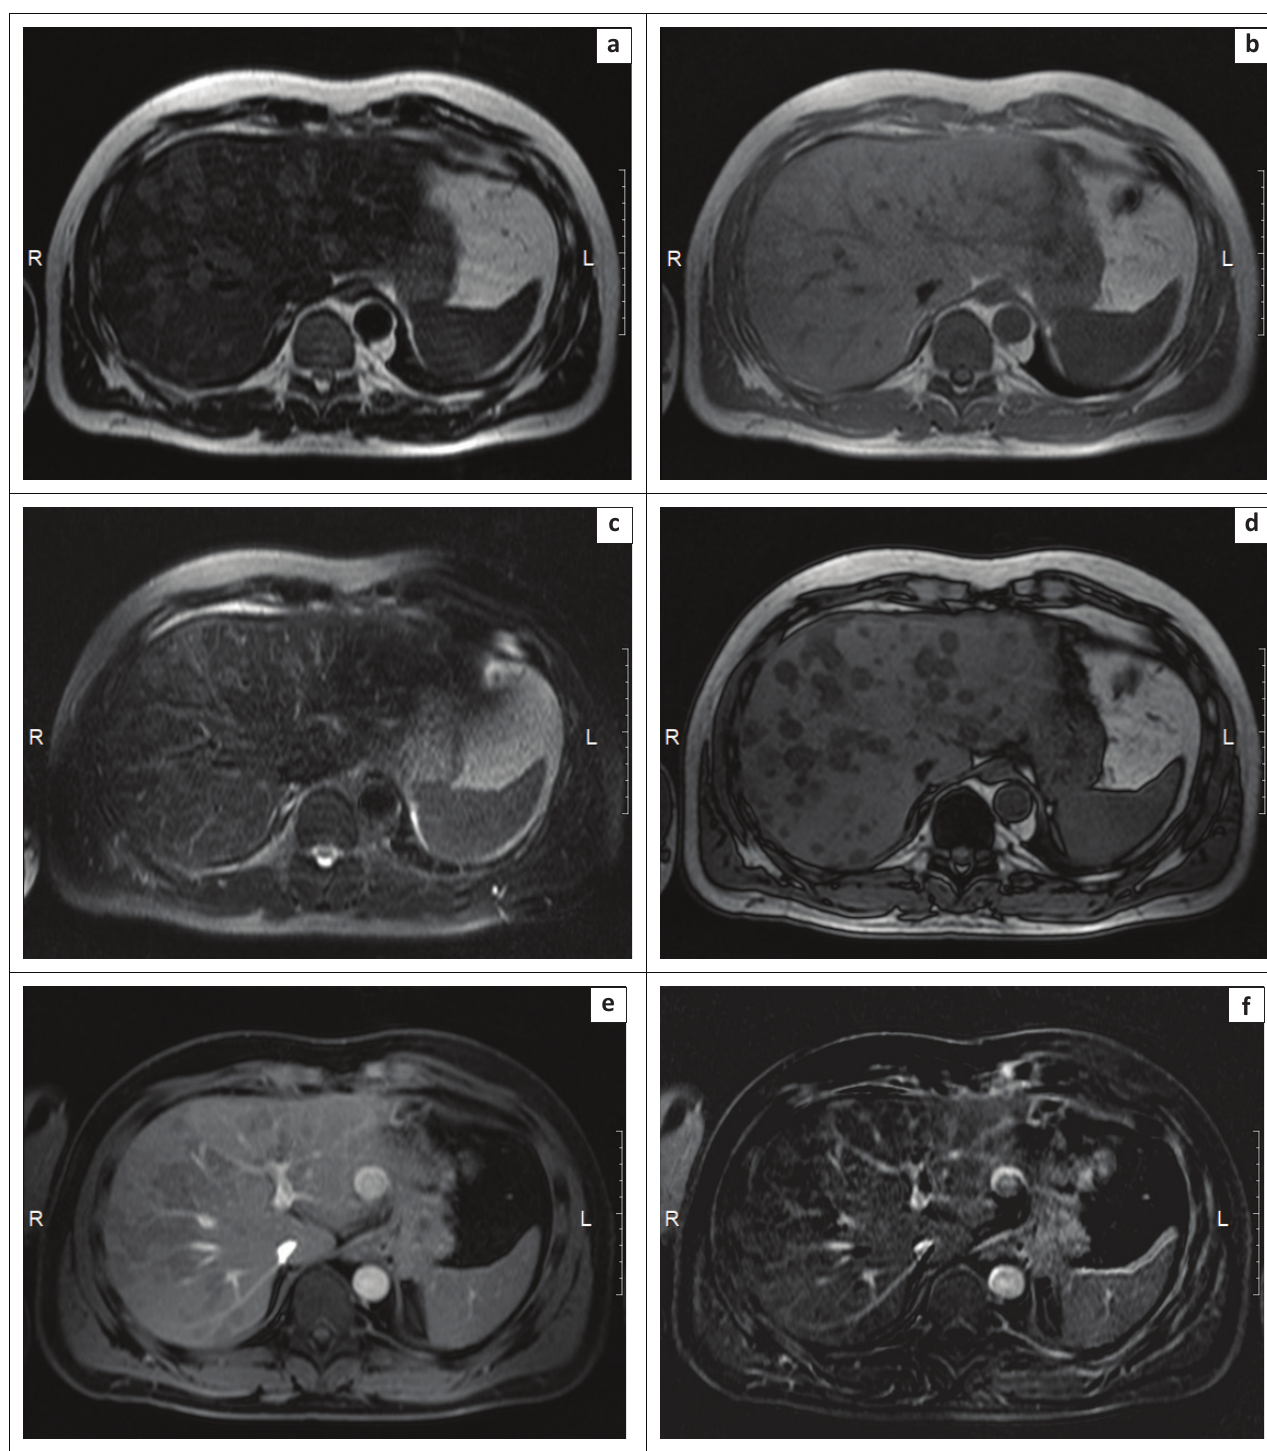
FIGURE 2: Contrast-enhanced abdominal MRI demonstrated a multinodular (‘patchy’) appearance in the hepatic parenchyma: (a) T2-weighted image; (b) in-phase gradient echo image; (c) T2-FatSat-weighted image; (d) out-of-phase gradient echo image; (e) T1-weighted 3D gradient echo LAVA-flex sequence (post-gadolinium) and (f) subtracted